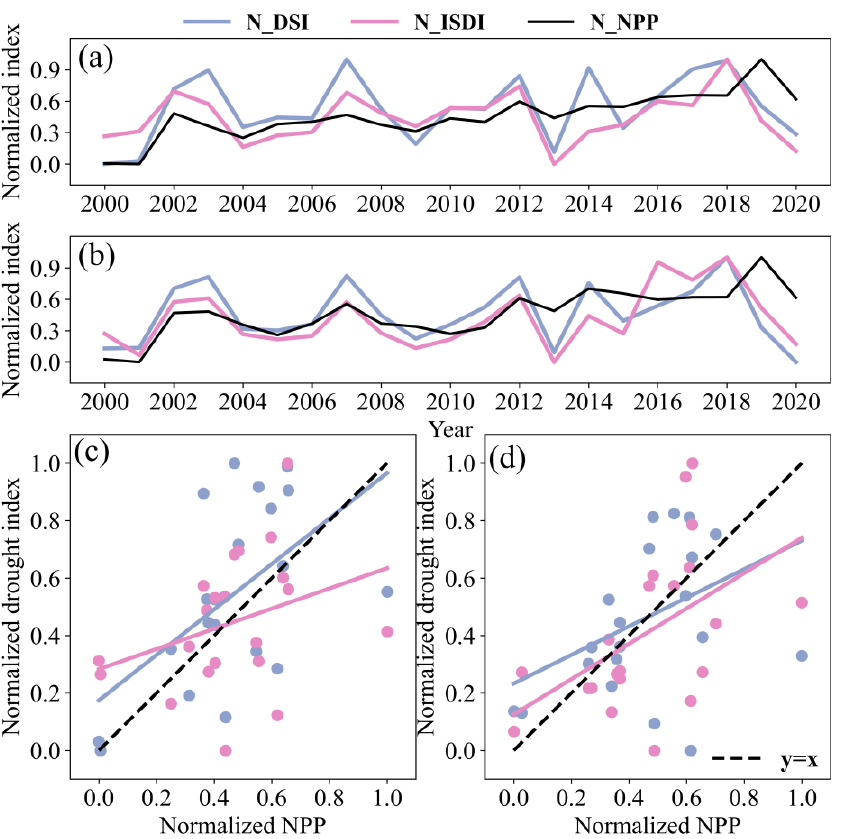
Figure 6. Temporal variation in integrated drought index and NPP during the growing season from 2000 to 2020: ( a ) grassland and forest area and ( b ) farmland area. The scatter plot distribution of integrated drought index and NPP: ( c ) grassland and forest area and ( d ) farmland area.